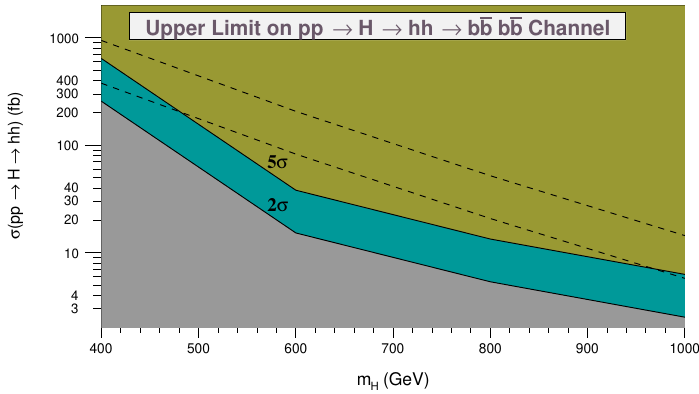
Figure 13 . Upper limit on (cid:27) ( pp H hh ) (fb) as a function of m H (GeV) for the b (cid:22) bb (cid:22) b channel. ! ! The solid (dashed) lines show the 2 (cid:27) -5 (cid:27) band on taking 0% (5%) systematic uncertainties. Discussion about m = 400 H